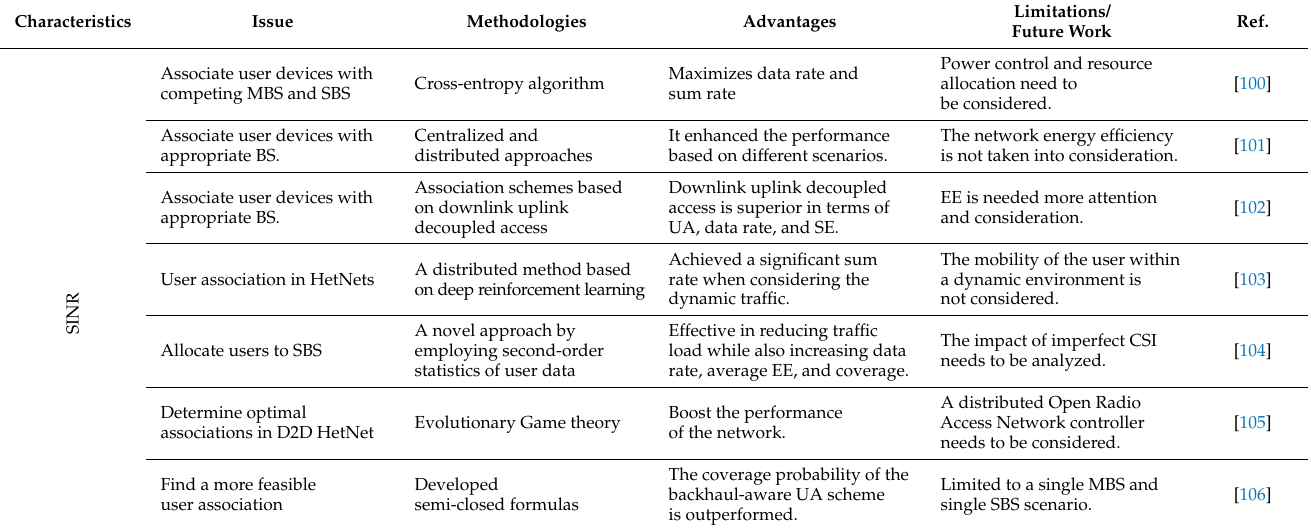
Figure 6. User association in HetNet. Table 3. Summary of the related work for user